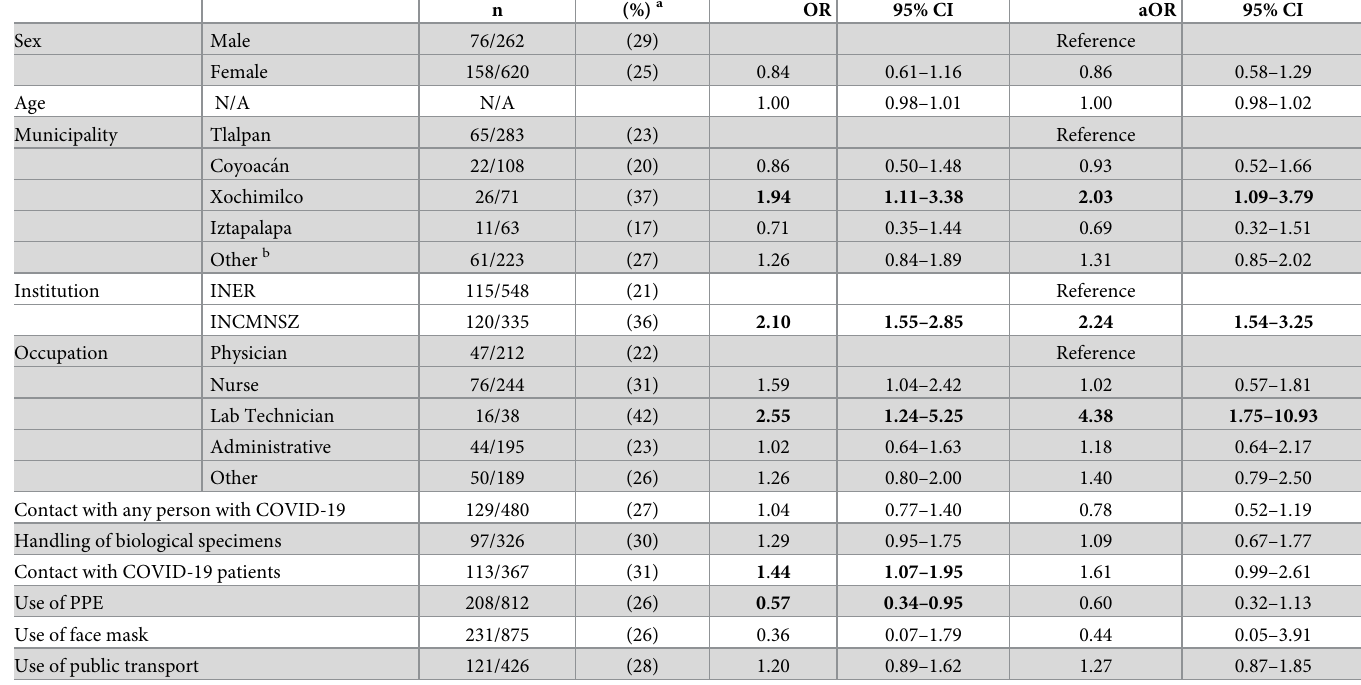
Table 2. Characteristics of prevalent cases and associated risks of having a positive serological test at baseline in healthcare workers of the two largest COVID-19 referral hospitals in Mexico City, October 2020-June